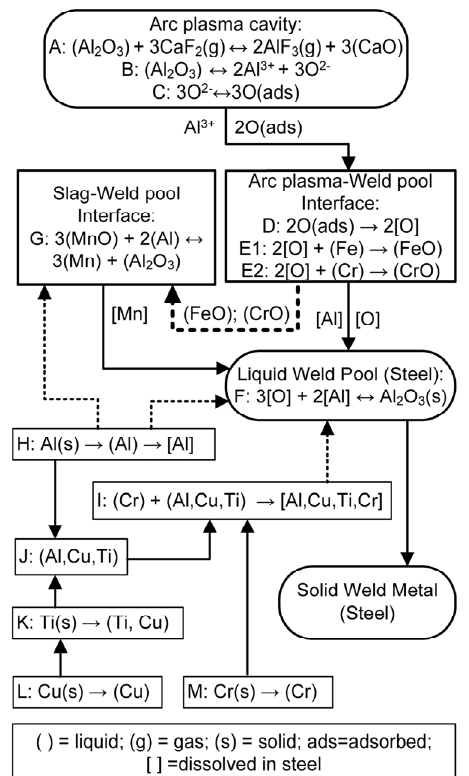
Figure 12. SAW reaction flow diagram with Al, Ti, Cu, and Cr powder addition reactions.